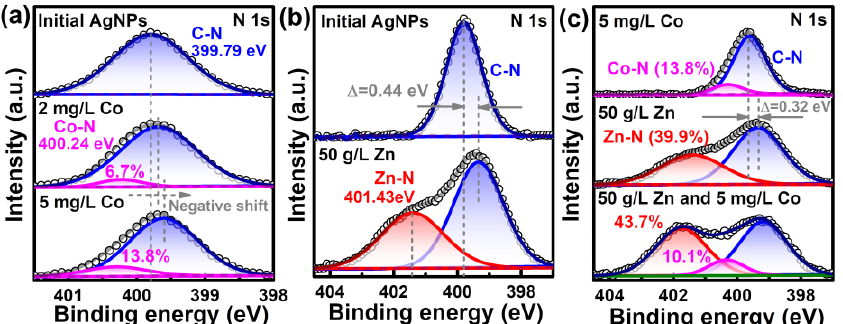
Figure 8. High-resolution XPS spectra comparisons of N 1s: ( a ) PVP-AgNPs dispersions with or without Co 2+ ; ( b ) PVP-AgNPs dispersions with or without Zn 2+ ; ( c ) PVP-AgNPs dispersions con- taining Co 2+ , Zn 2+ , or Co 2+ – Zn 2+ co-existed ions.